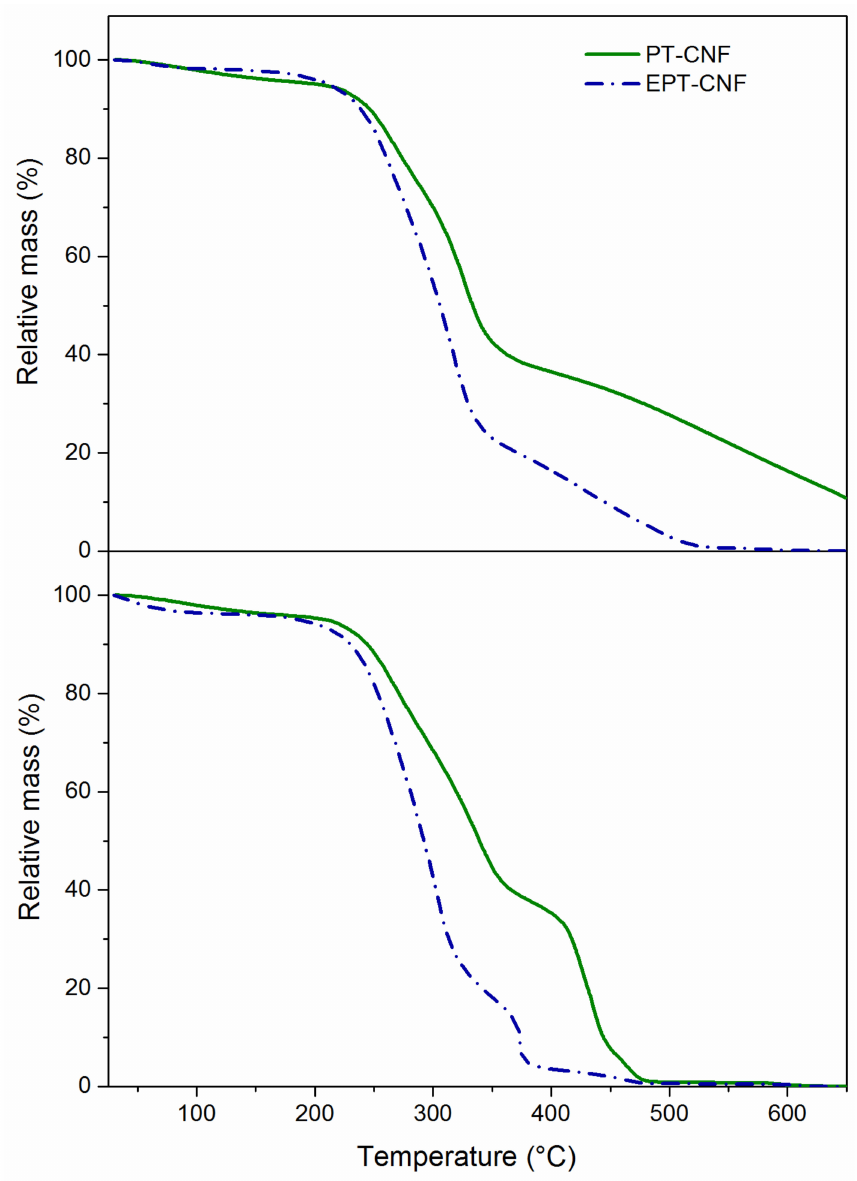
Figure 4. Thermograms of (green full line) PT-CNF and (blue dash-dotted line) EPT-CNF in ( top ) nitrogen and ( bottom )